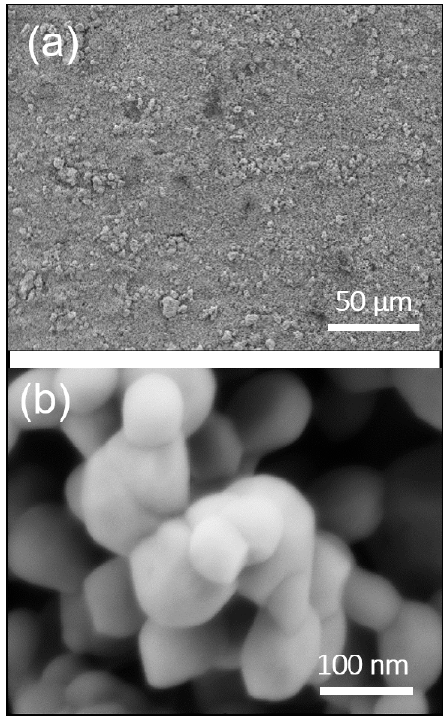
Figure 1. The typical FESEM images with low ( a ) and high ( b ) resolution ratios of obtained functional superhydrophobic nano-Bi 2 O 3 films.